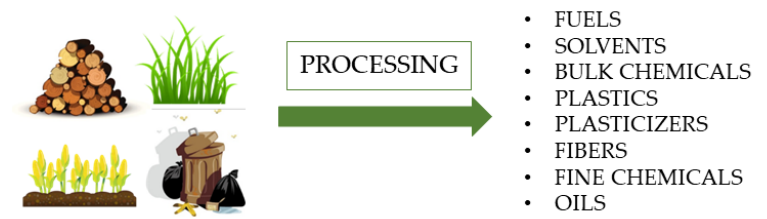
Figure 1. Possible methods of biomass processing in chemical industry. number of publications, e.g., in ScienceDirect (Figure 2).